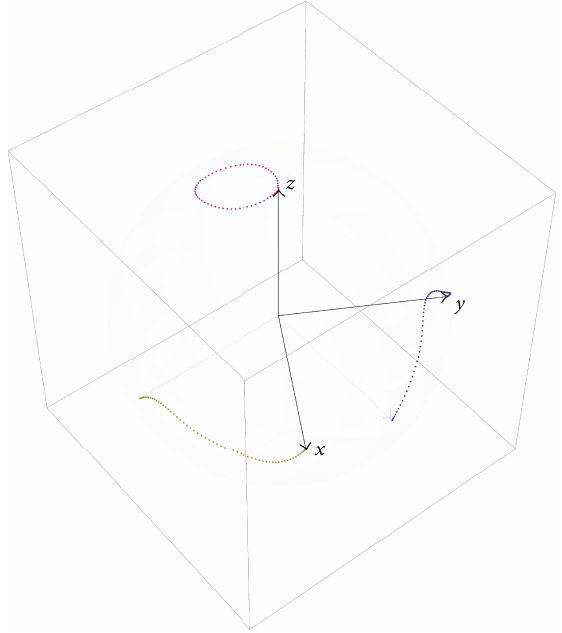
Figure 1: Motion of the body frame of the spacecraft in the solution of a minimum-time rest-to-rest counterclockwise rotation of π / 3 (rad) about the z -axis. The traces of the x -, y -, and z -axes on the unit sphere are represented in yellow, blue, and purple,